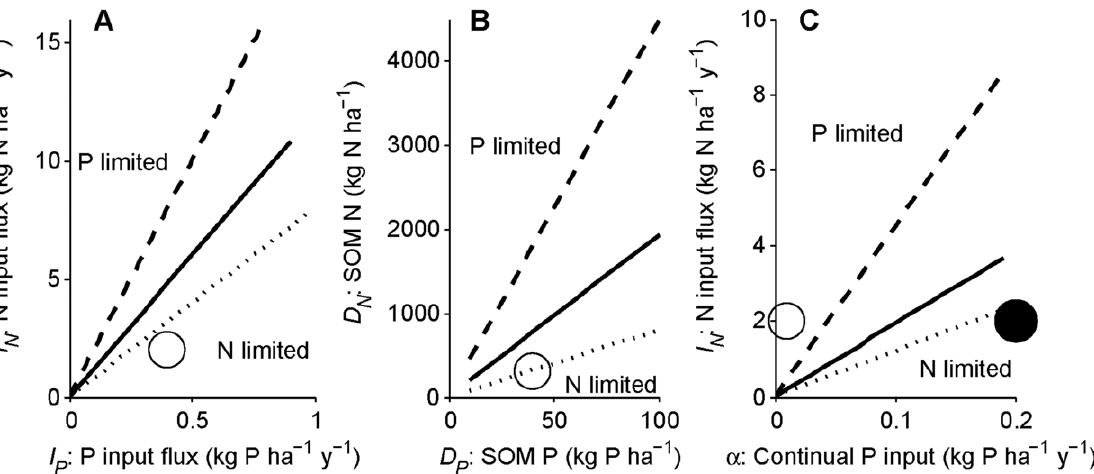
Figure 5. Approximate determination of N versus P limitation at different timescales. (A) The beginning of the intermediate timescale (beginning of succession), (B) end of the intermediate timescale (end of succession), and (C) terminal steady state (end of long-term ecosystem development) are shown with simplifying assumptions from Table 2 and no symbiotic N fixation. (A) At the beginning of succession there is negligible soil organic matter (SOM), so limitation is determined by input fluxes (the axes), plant demand, and litter N versus P mineralization. The dividing line between N and P limitation (condition 13) is plotted with parameters in Table 1 and 10 kg C ha 2 1 initial plant biomass (solid line) as well as for high (litter N:P=20, P:N mineralization rates=1.5; dashed line) and low (litter N:P=8, P:N mineralization rates=1; dotted line) parameter values. The circle represents parameters in Table 1. Ecosystems with high rock P inputs would be at the right end of the panel. Ecosystems with high N deposition would be near the top of the panel. (B) At the end of succession, mineralization from SOM far exceeds the balance of abiotic inputs and losses in unpolluted ecosystems, so N versus P limitation is determined by SOM N and P (the axes), plant N:P demand, and the mineralization of litter and SOM N versus P (condition 15). The lines are as in (A), and the circle is the initial SOM N and P in Fig. 2. (C) At the terminal steady state, N versus P limitation is determined by the balance of continual inputs and losses, plant N:P demand, and the mineralization of litter and SOM N versus P (condition 18). Axes are N and P input fluxes. Lines and open circle as in (A), with the closed circle indicating the input fluxes for Fig. 4.